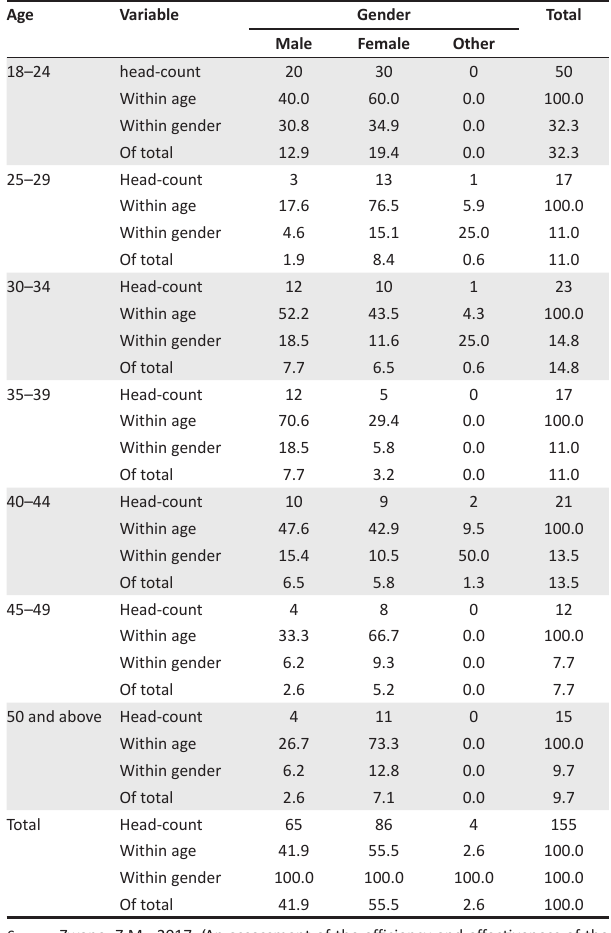
TABLE 1 : The overall gender distribution by